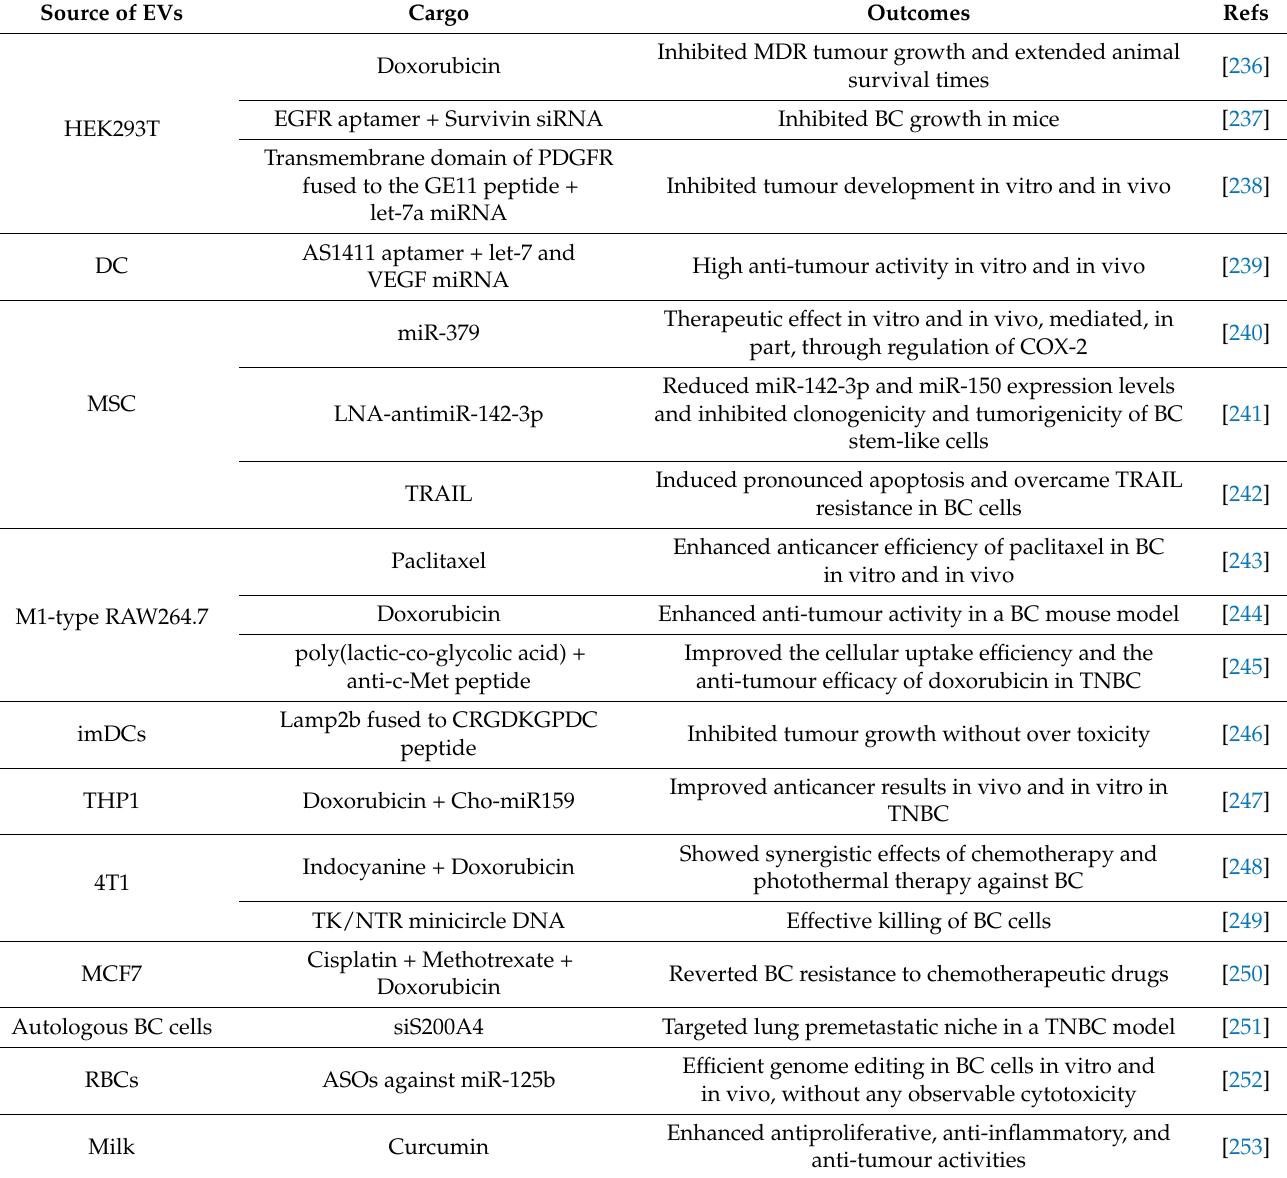
Table 3. List of main extracellular vesicles used as delivery vehicles for therapeutic